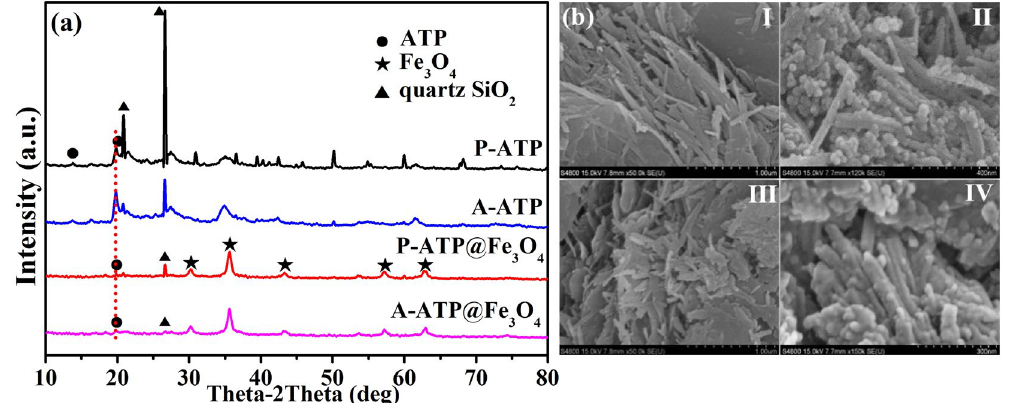
Figure 1. ( a ) XRD patterns and corresponding diffraction peaks for P-ATP@Fe 3 O 4 and A-ATP@Fe 3 O 4 . The original P-ATP and A-ATP serves as control. ( b ) SEM images of (I) P-ATP, (II) P-ATP@Fe 3 O 4 , (III) A-ATP, (IV) A-ATP@Fe 3 O 4